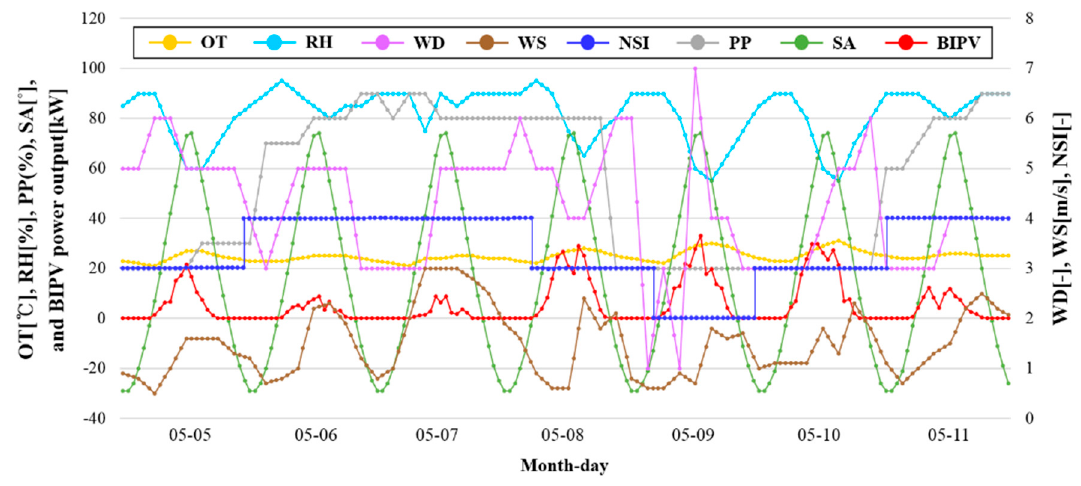
Figure 5. Characteristics of seven weather features and BIPV power output for 7 days.